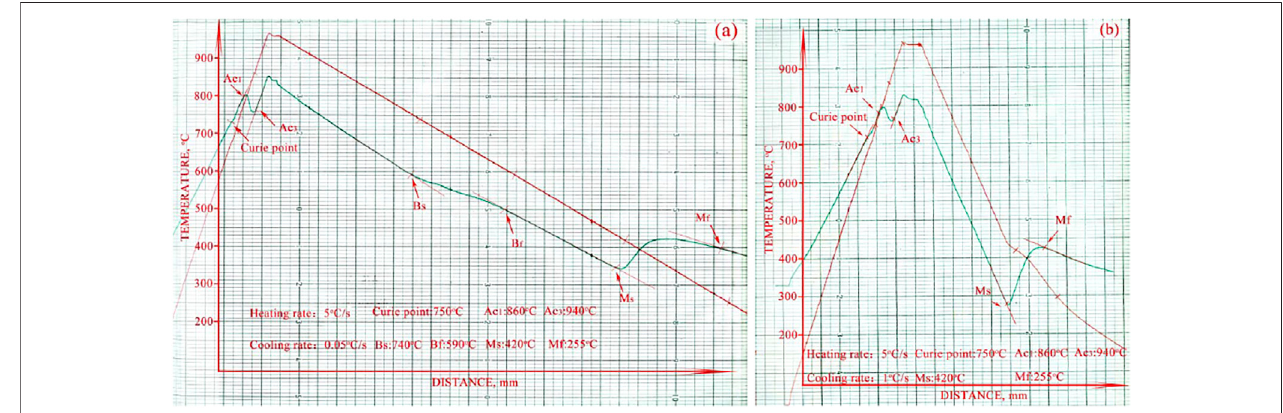
FIGURE 3 | The CCT curves of NSM steel (A) 5 ° C/s heating rate and 0.05 ° C/s cooling rate, (B) 5 ° C/s heating rate and 1 ° C/s cooling rate.